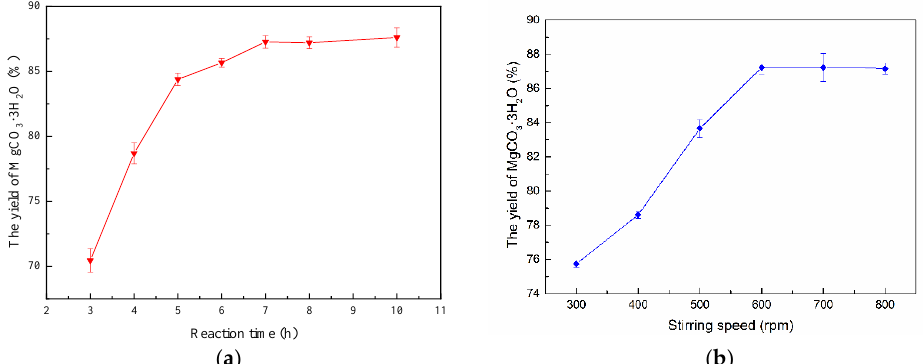
Figure 3. Effect of ( a ) reaction time (stirring speed = 600 rpm) and ( b ) stirring speed (reaction time = 7 h) on the yield of MgCO 3 ·3H 2 O at V waste bitterns : V R3N : V isoamyl alcohol = 1:4.8:4.8 and reaction temperature = 313.15 K.